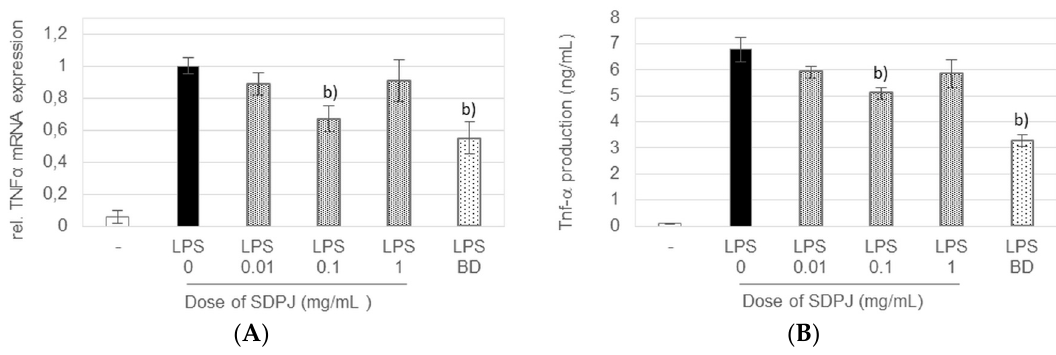
Figure 3. Effect of spray-dried potato juice (SDPJ) and budesonide (BD) on mRNA expression of TNF- α ( A ) and the production of TNF- α ( B ) in a co-culture system of Caco-2 cells and RAW264.7 macrophages nonstimulated ( − ) or stimulated by LPS. Values represent the means ± SD ( n = 3). b) p < 0.05 vs. the LPS-treated group.